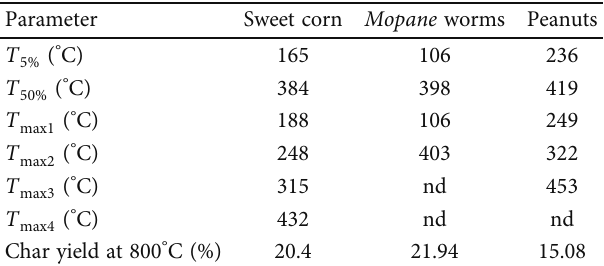
Char yield at 800 ° C